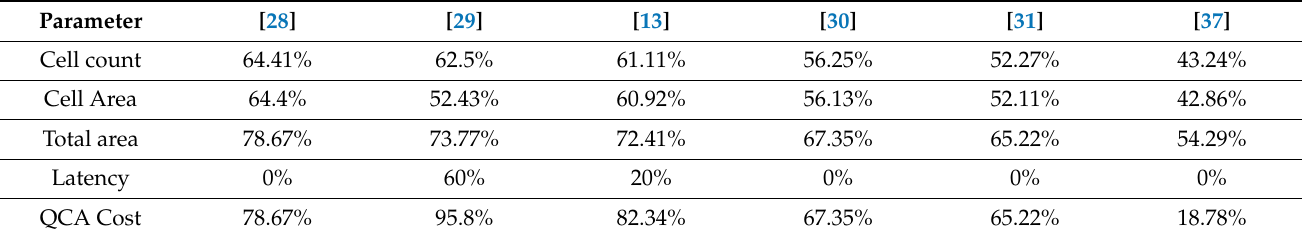
Table 7. Performance comparison of proposed DFF.